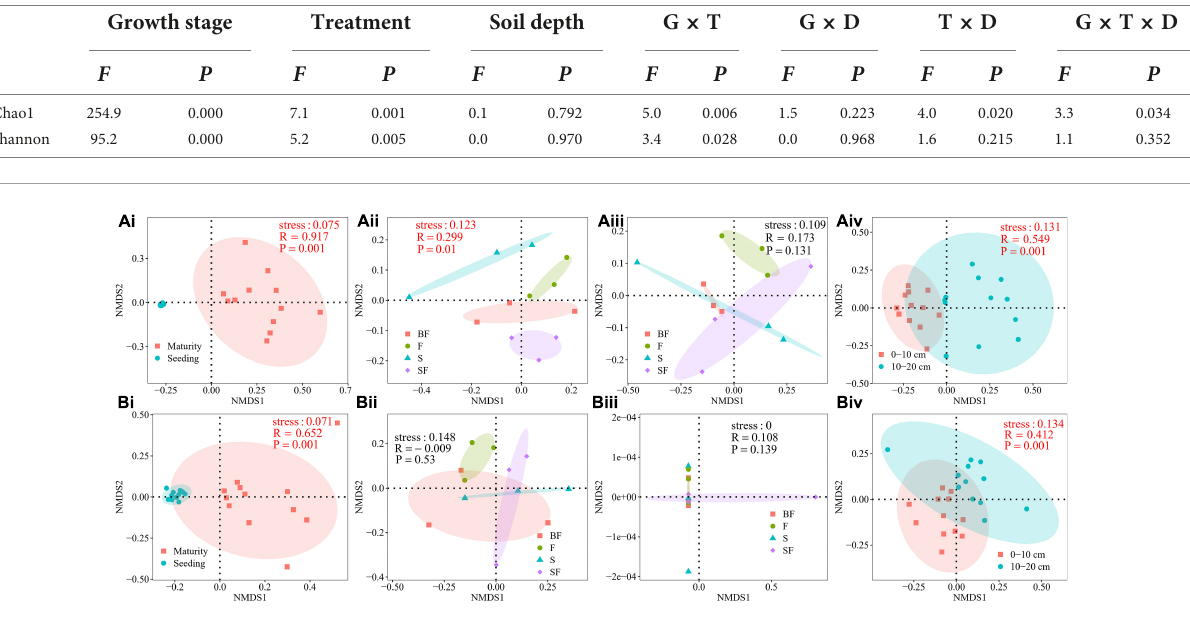
FIGURE2 (A) Non-metric multidimensional scaling (NMDS) analysis of soil bacterial community composition at 0–10 cm depth. (Ai) growth stages, (Aii) different treatments at seedling stage, (Aiii) different treatments at maturity stage, (Aiv) different soil depths at seedling stage. (B) NMDS analysis of soil bacterial community composition at 10–20 cm depth. (Bi) growth stages, (Bii) different treatments at seedling stage, (Biii) different treatments at maturity stage, and (Biv) different soil depths at maturity